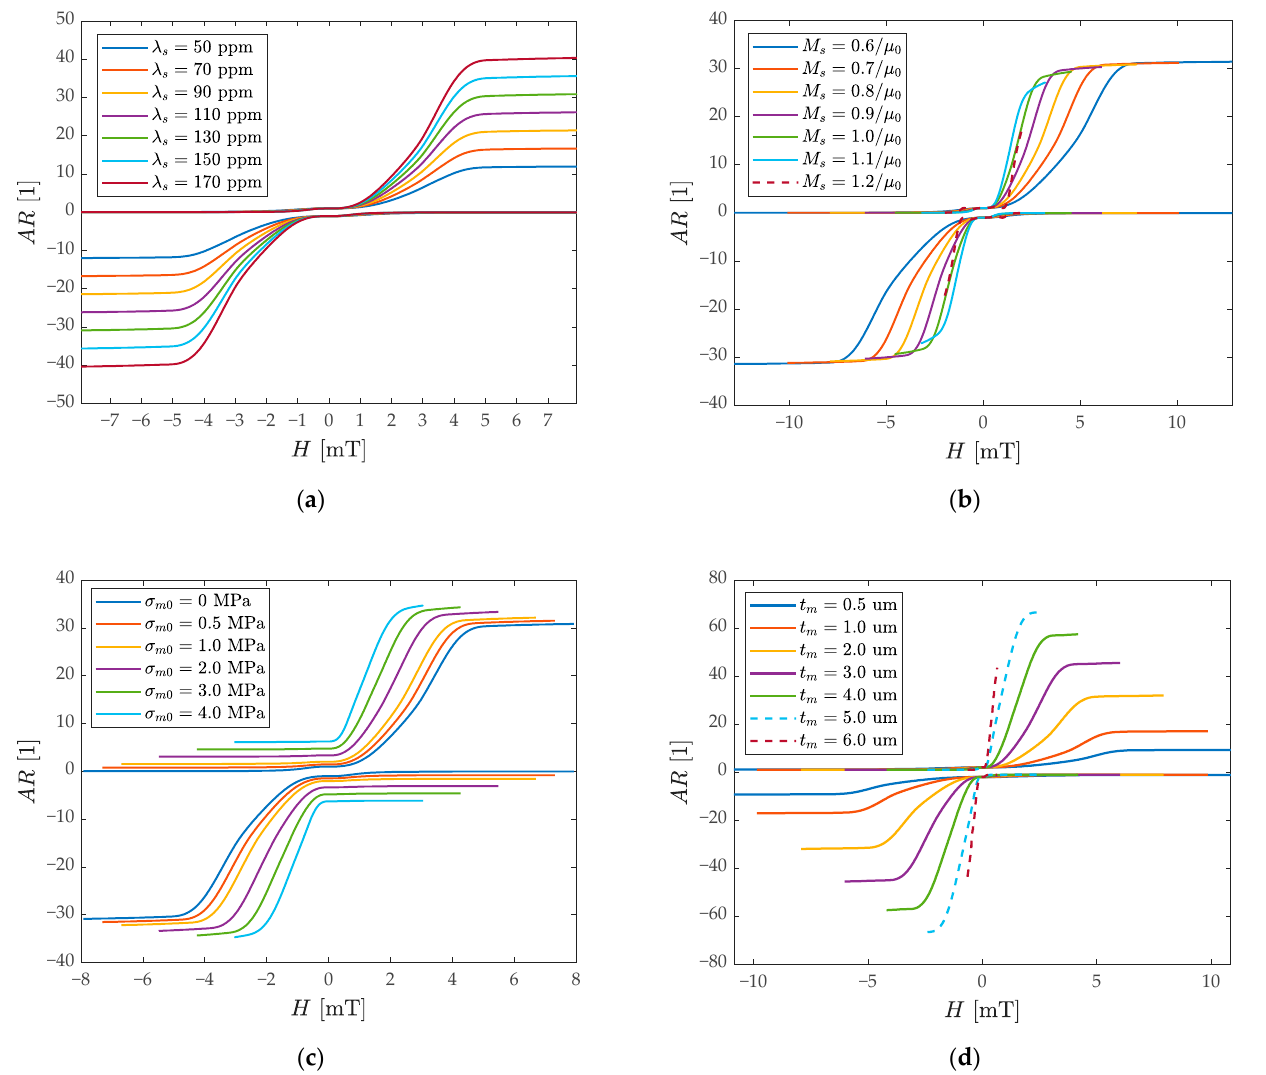
Figure 5. Influence of key materials and geometric parameters on the AR magnetic output curves: ( a ) the response to the AR when changing the saturation magnetostriction λ s ; ( b ) the response to the AR when changing the saturation magnetization M s ; ( c ) the response to the AR when changing the film tensile prestress σ m 0 ; ( d ) the response to the AR when changing the magnetostrictive film thickness t m